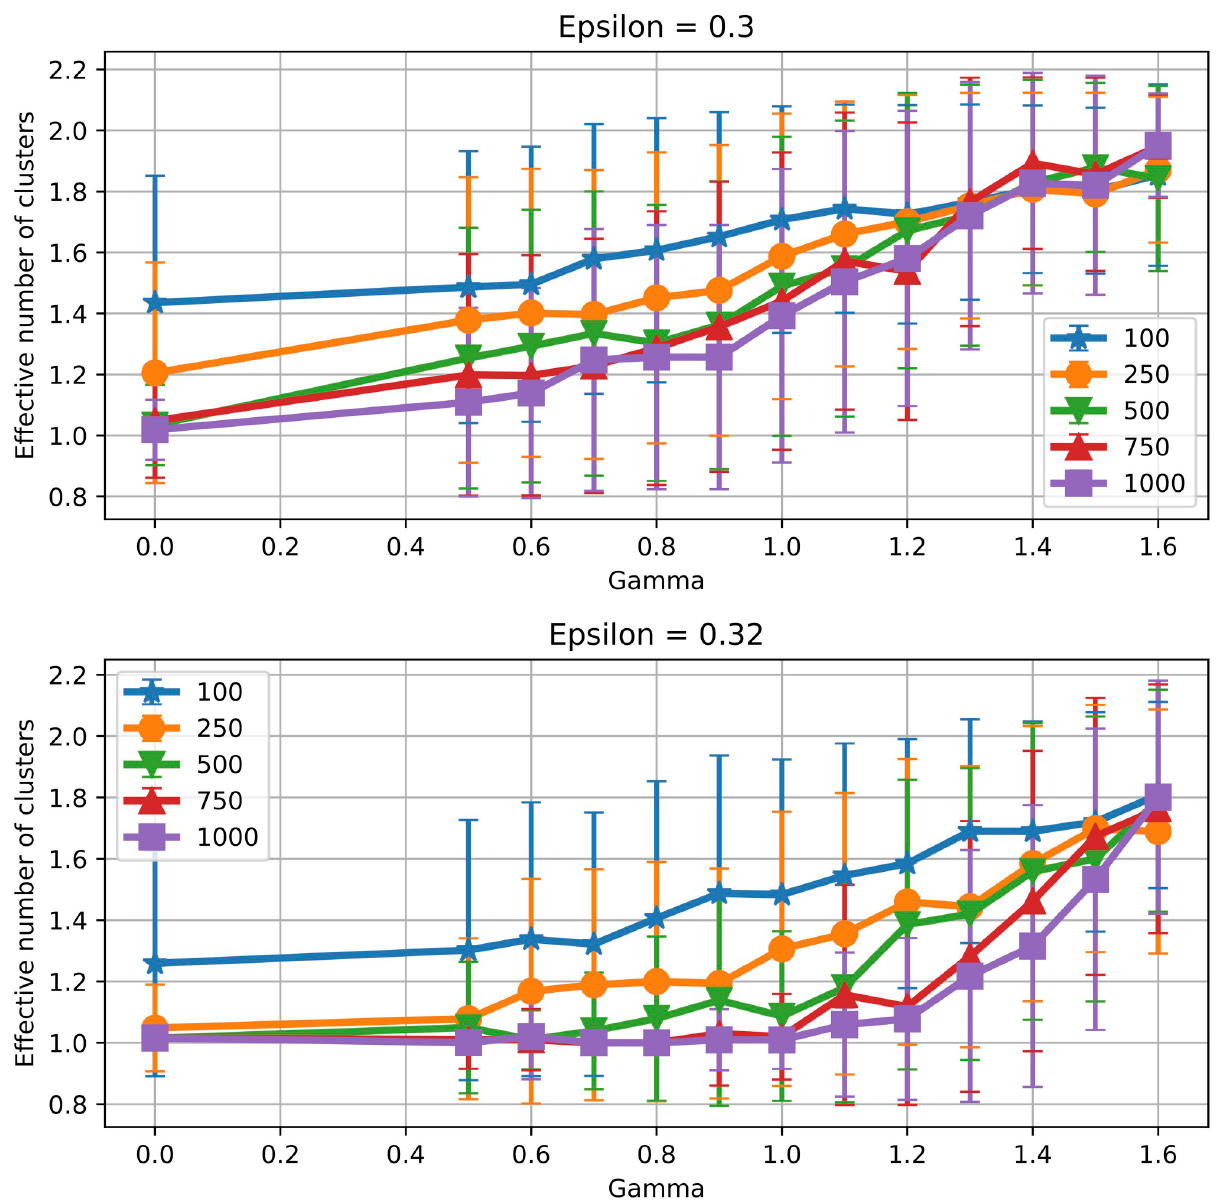
Fig 7. Finite size effects: Number of clusters with algorithmic bias. Effective number of clusters obtained for various ε , γ and N . Values are averaged over 200, 150, 100, 100 and 100 runs for N 2 {100, 250, 500, 750, 1000}, respectively. Error bars show one standard deviation from the mean.